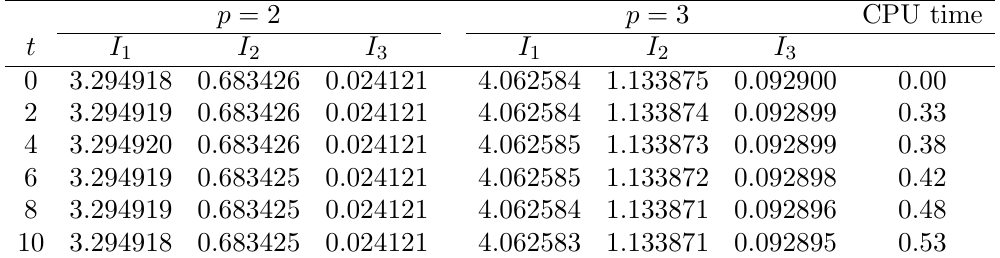
Table 4. Invariants on 0 ≤ x ≤ 100 for N = 400, ∆ t = 0 . 1, c = 0 . 1 at different final times.